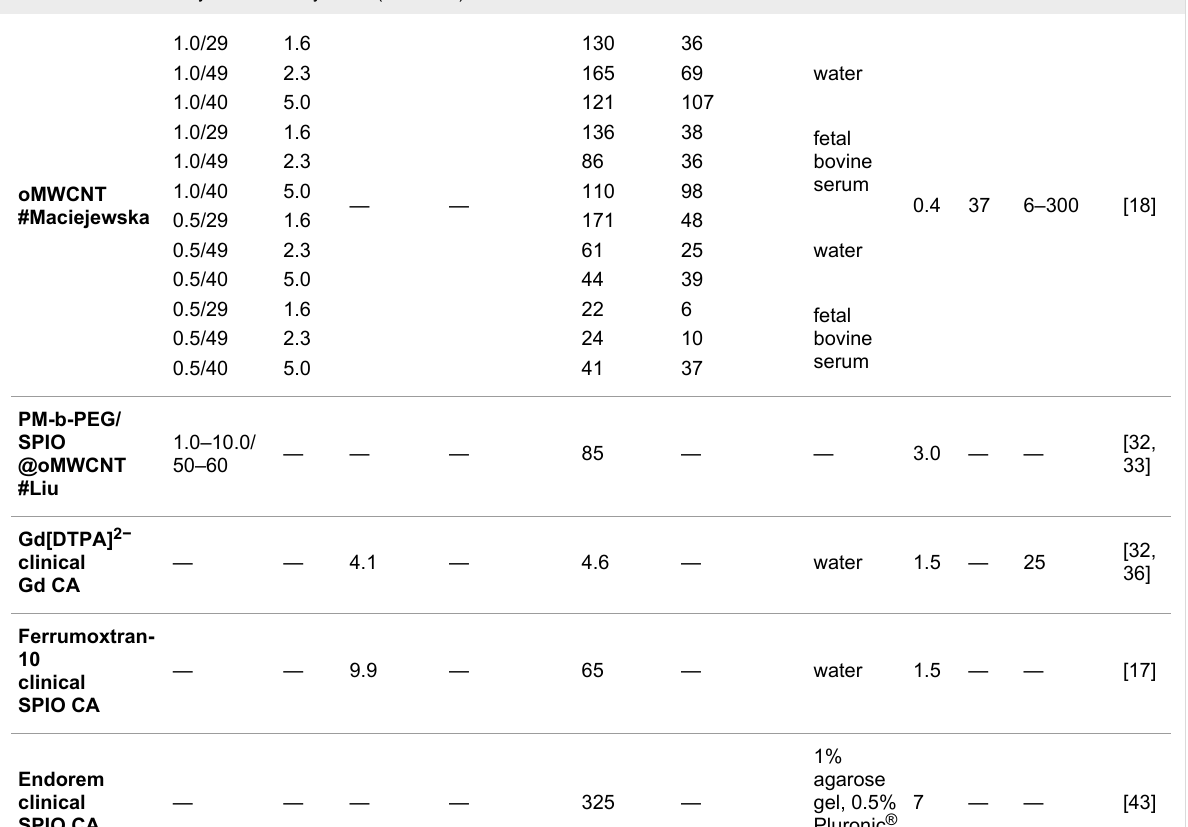
Table 1: In vitro relaxivity of MWCNT hybrids. a (continued)